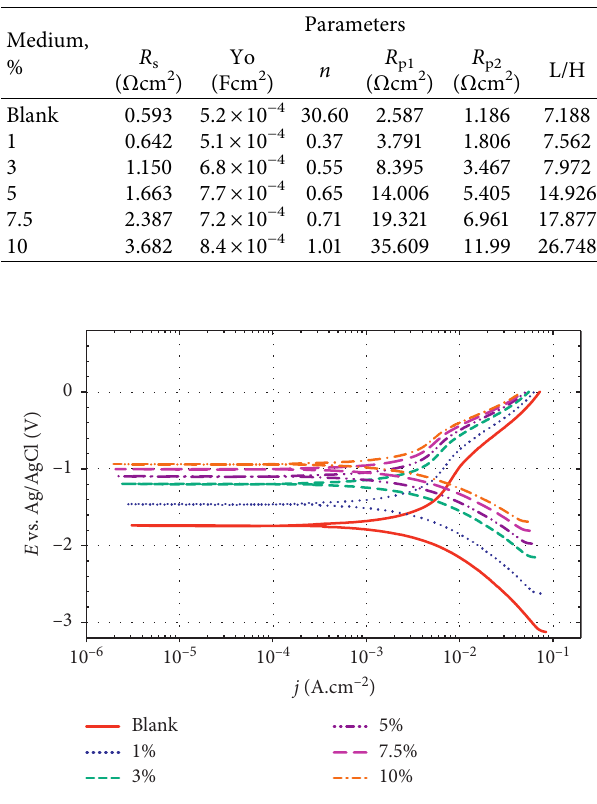
Figure 5: Potentiodynamic polarization designs of steel alloy 4130 sample engrossed in 3.5 wt.% NaCl solution and diverse loads of LI.